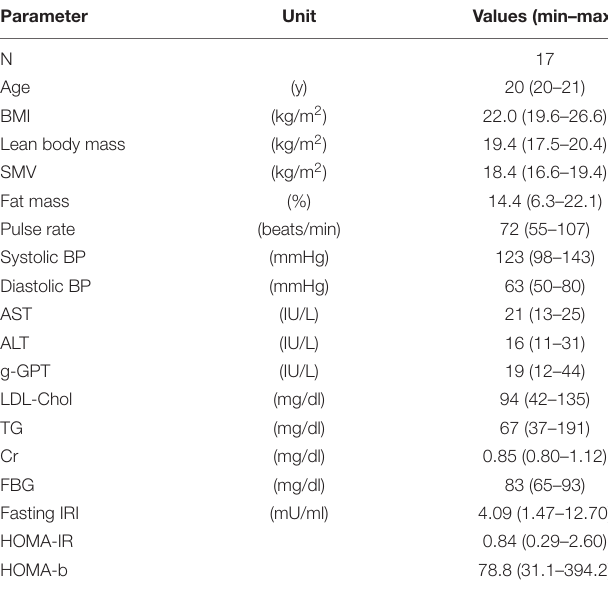
TABLE 1 | Basic characteristics of subjects.